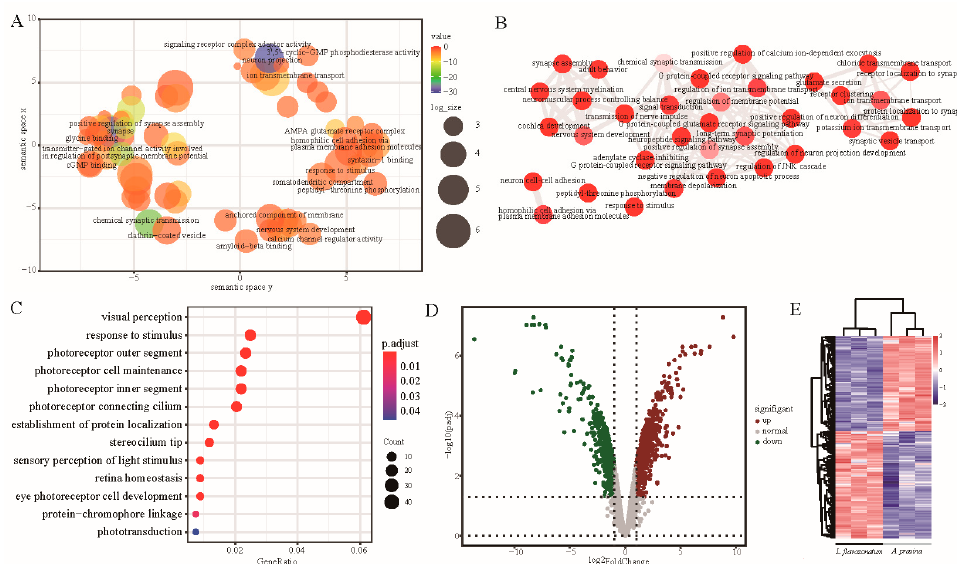
Figure 5. GO terms enriched by module genes and differential expression pattern. ( A ) REVIGO clusters of significantly overrepresented GO terms for genes in dark-green module. ( B ) Interactive graph of significantly overrepresented GO terms in dark-green module. ( C ) Dot plot of significant GO terms enriched by genes in blue module. ( D ) Volcano plot of differential expression genes (DEGs) in two modules between two snakes. The green dots indicate the genes upregulated in eyes of A. prasina and red dots represent genes upregulated in L. flavozonatum ( E ) Heatmap shows expression pattern of DEGs in two modules.